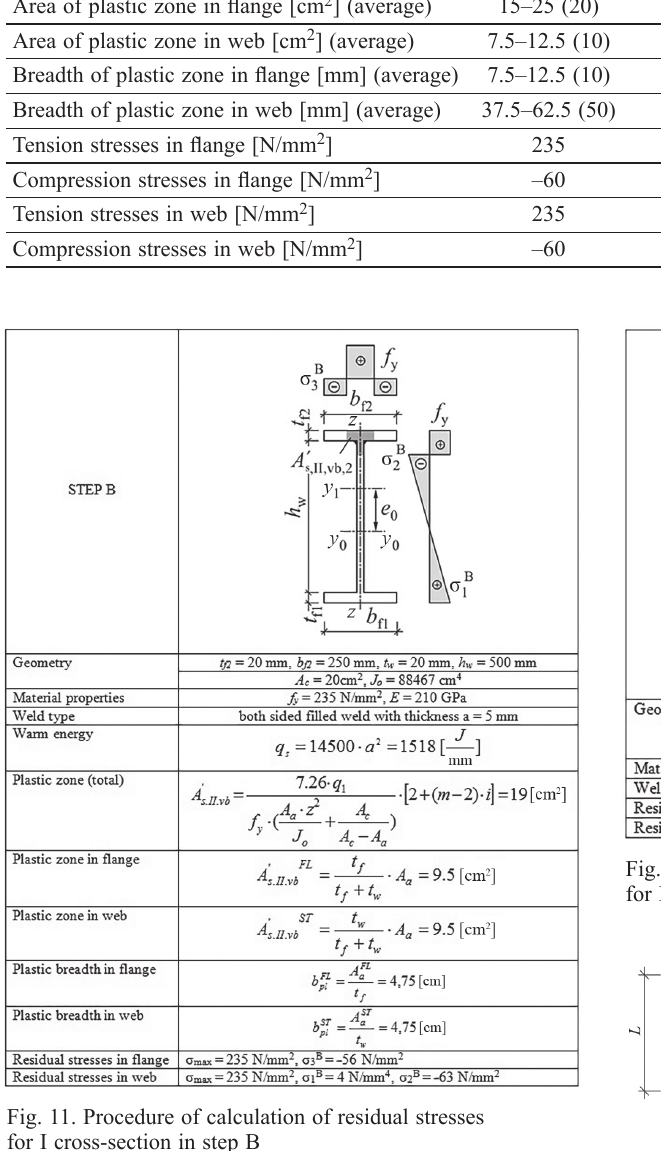
Fig. 13. Geometrical and material properties of the analysed compressed